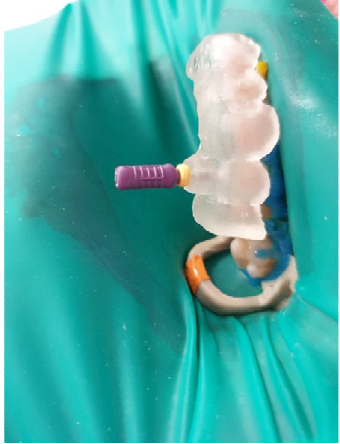
Figure 22. Image presenting endodontic guide placed on patient’s teeth. Root canal was negotiated with a C-Pilot file.